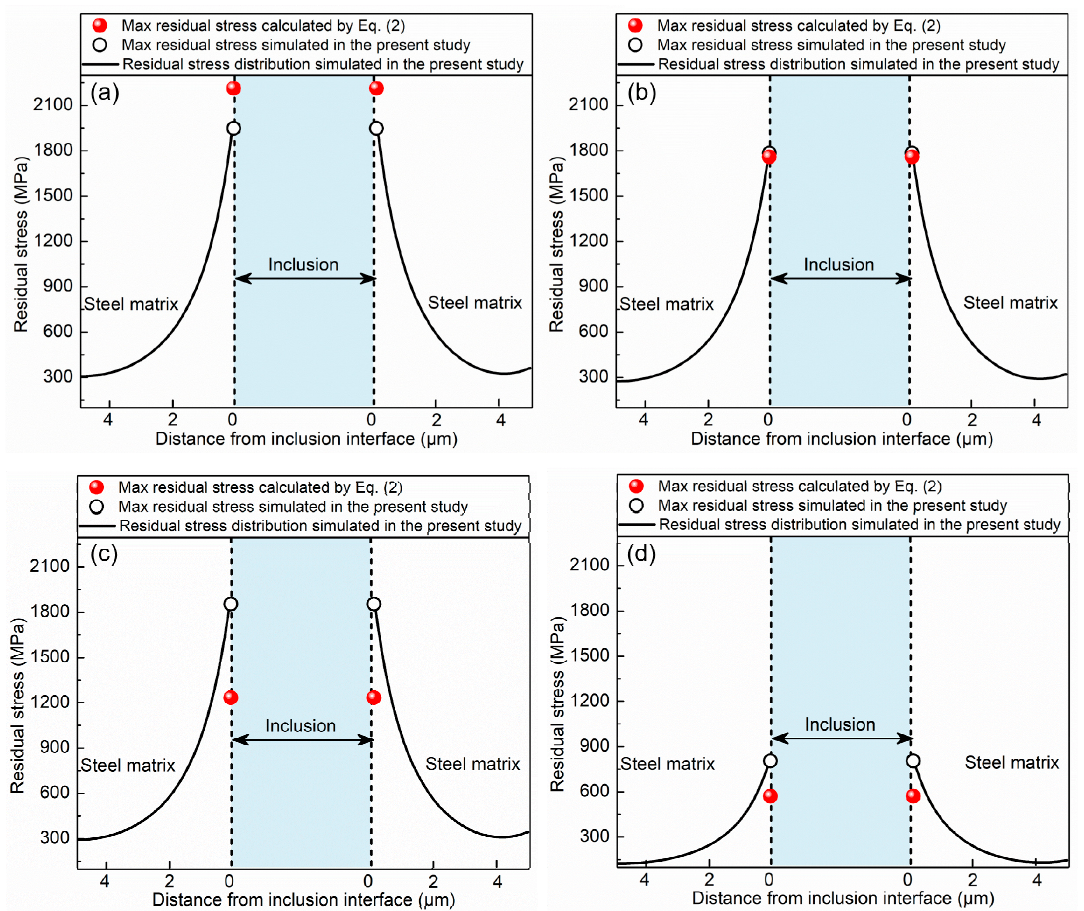
Figure 5. Comparison of simulated residual stresses and the maximum residual stress on the interface between steel matrix and inclusions calculated with Equation (2): ( a ) Mg-Al-O; ( b ) Al-Ca-O-S; ( c ) TiN; ( d ) MnS.